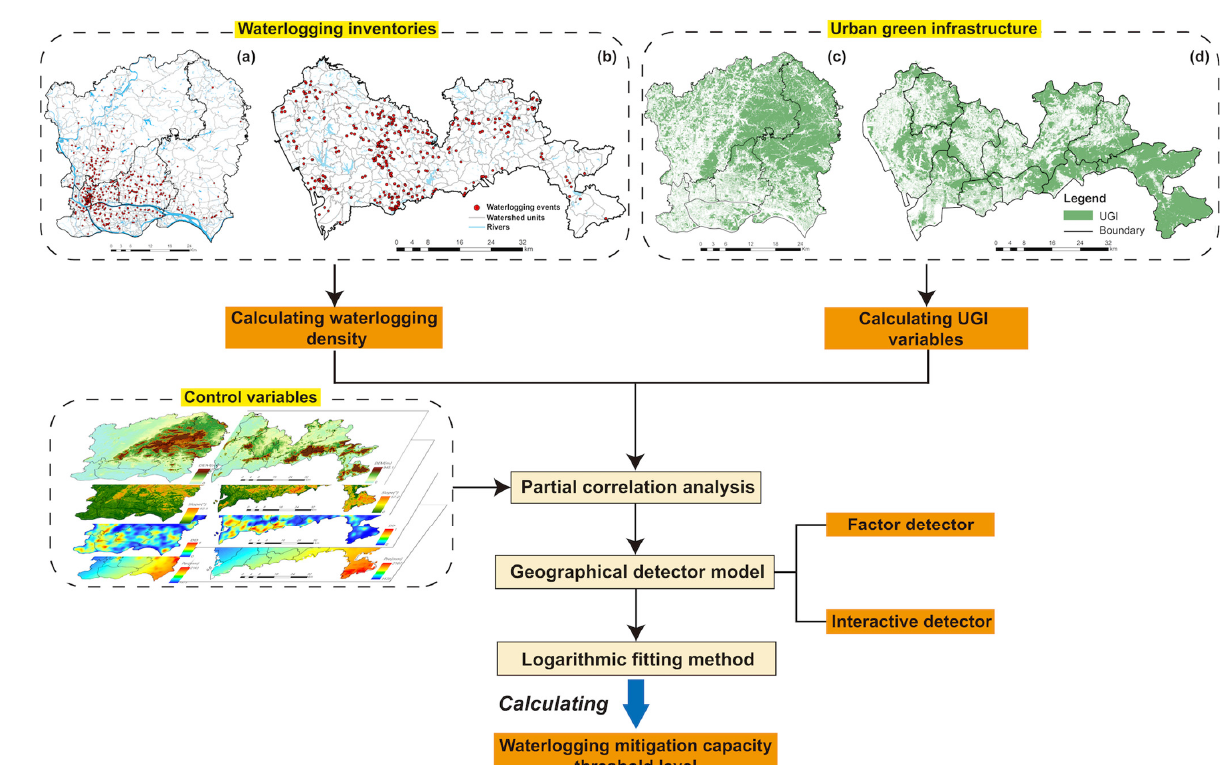
Figure 2. The integrated framework of this study.